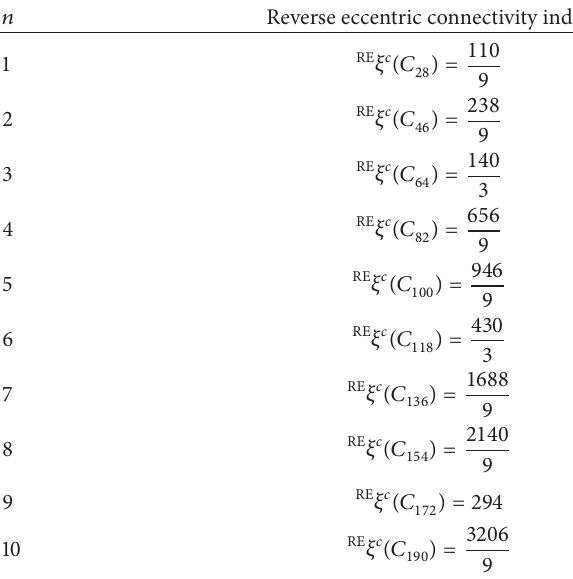
Table 4: Some exceptional cases of reverse eccentric connectivity index of fullerene 𝐶 18𝑛+10